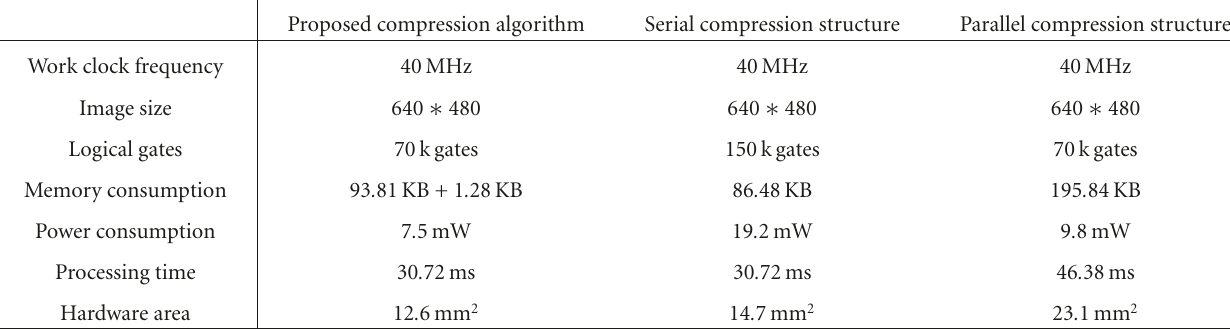
Table 5: Comparison results of hardware cost, power dissipation, and processing